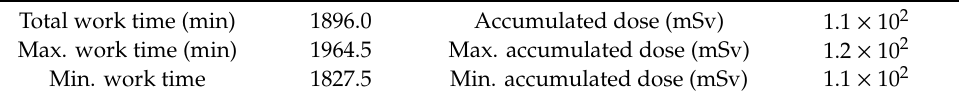
Table 7. Work time and estimated dose for the fragmentation of the lower part.